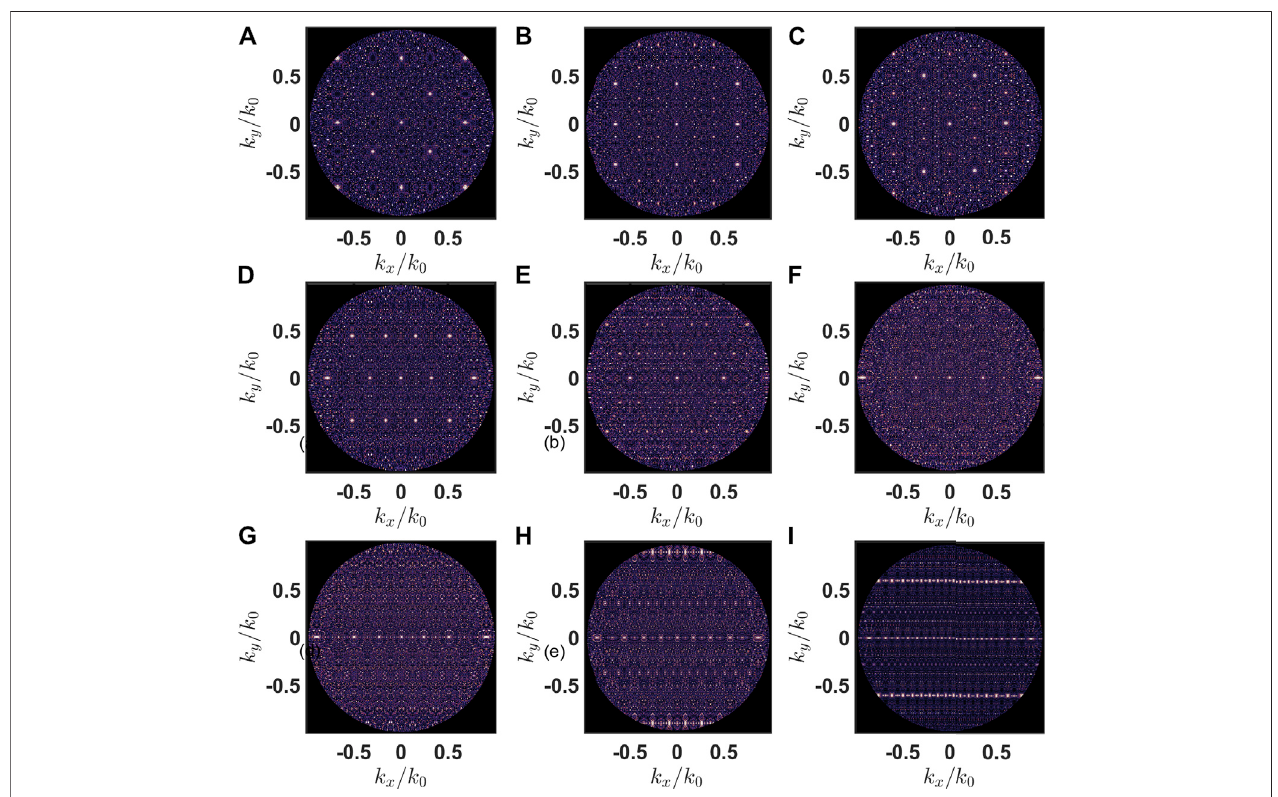
FIGURE 2 | Calculated structure factors corresponding to the prime arrays shown in Figure 1 . These diffraction patterns are visualized using the fi fth root of the intensity to enhance the contrast.